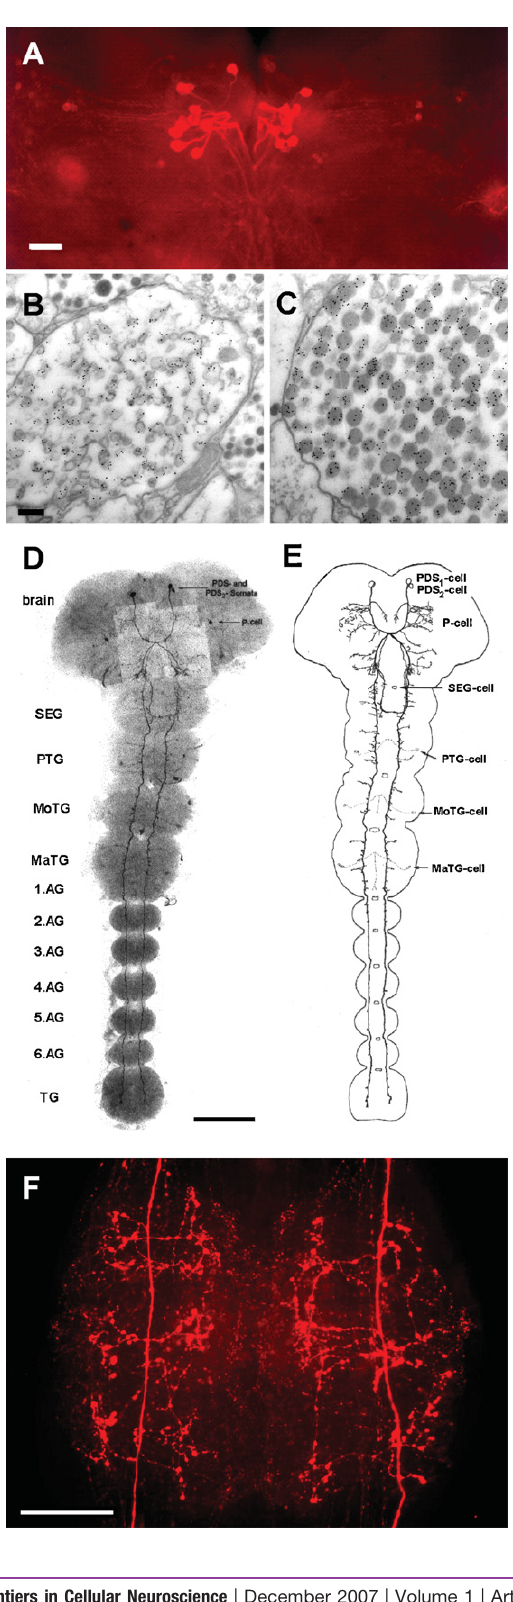
Figure 1. PSK-ir neurons in the central nervous system of Periplaneta . ( A ) PSK-immunostaining (whole-mount) in adult brain. Bar, 100 m m. ( B , C ) Elec- tron micrograms displaying immuno-gold labeling of axon terminals in the storage lobe of the corpus cardiacum. Bar, 100 m m. ( D ) PSK-immunostaining (whole-mount) in a 22-day-old embryo. Two cell pairs, the protocerebral descending sulfakinin-ir (PDS1 and PDS2) neurons run contralaterally to the SEG. The PDS1 neurons project longitudinally through all ganglia within the ventral nerve cord. By contrast, the PDS2 neurons turn back to the ipsilateral side in the posterior part of the SEG and ascend to the tritocerebrum. ( E ) Schematic view of D. Note the beginning development of arborizations of the PDS1 neurite within the thoracic areas. Other PSK-ir neurons are described in (Agricola and Bra¨unig, 1995). SEG, subesophageal ganglion; PTG, prothoracic ganglion; MoTG, mesothoracic ganglion; MaTG, metathoracic ganglion; AG, abdominal ganglion; TG, terminal ganglion. Bar, 200 m m. (F), PSK-immunos- taining (whole-mount) in the sixth AG of an adult animal. Note the intense staining of the PDS1 neurite arborizations characterized by varicosities. At each side three bilateral main branches sprout from the primary neurite. Bar, 100 m m